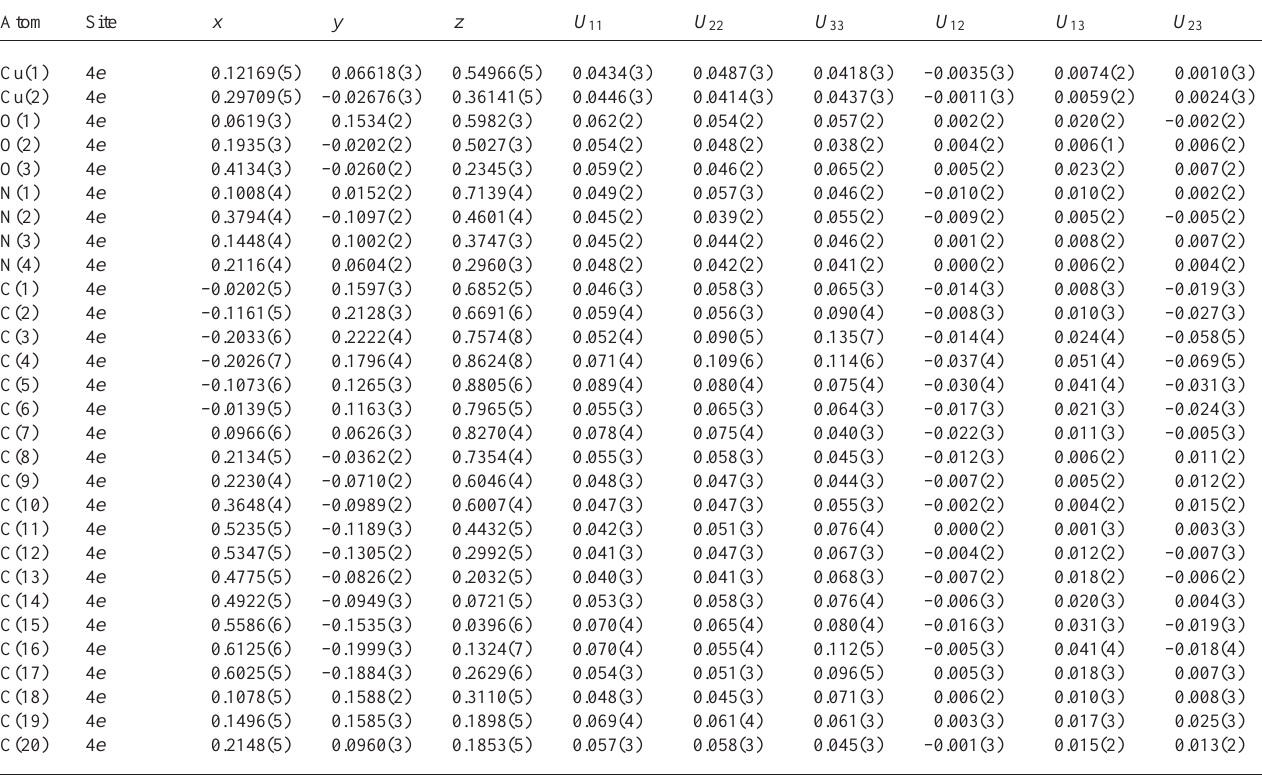
Table 3. Atomic coordinates and displacement parameters (in Å 2 )